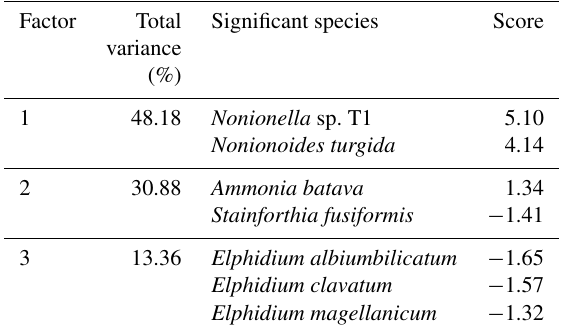
Table 1. Significant foraminiferal species and scores according to the correspondence